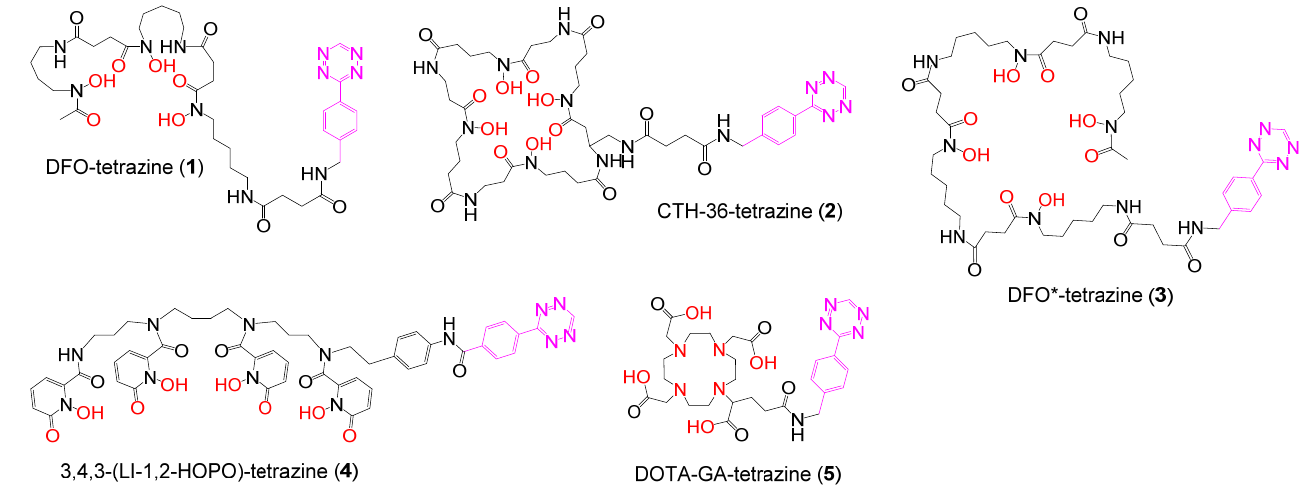
Figure 2. Structures of the target chelator derivatives DFO–tetrazine ( 1 ), CTH-36–tetrazine ( 2 ), DFO*–tetrazine ( 3 ), 3,4,3-(LI-1,2-HOPO)–tetrazine ( 4 ) and DOTA-GA–tetrazine ( 5 ). 89 Zr-coordinating atoms are depicted in red, and the tetrazine moiety is colored in pink.